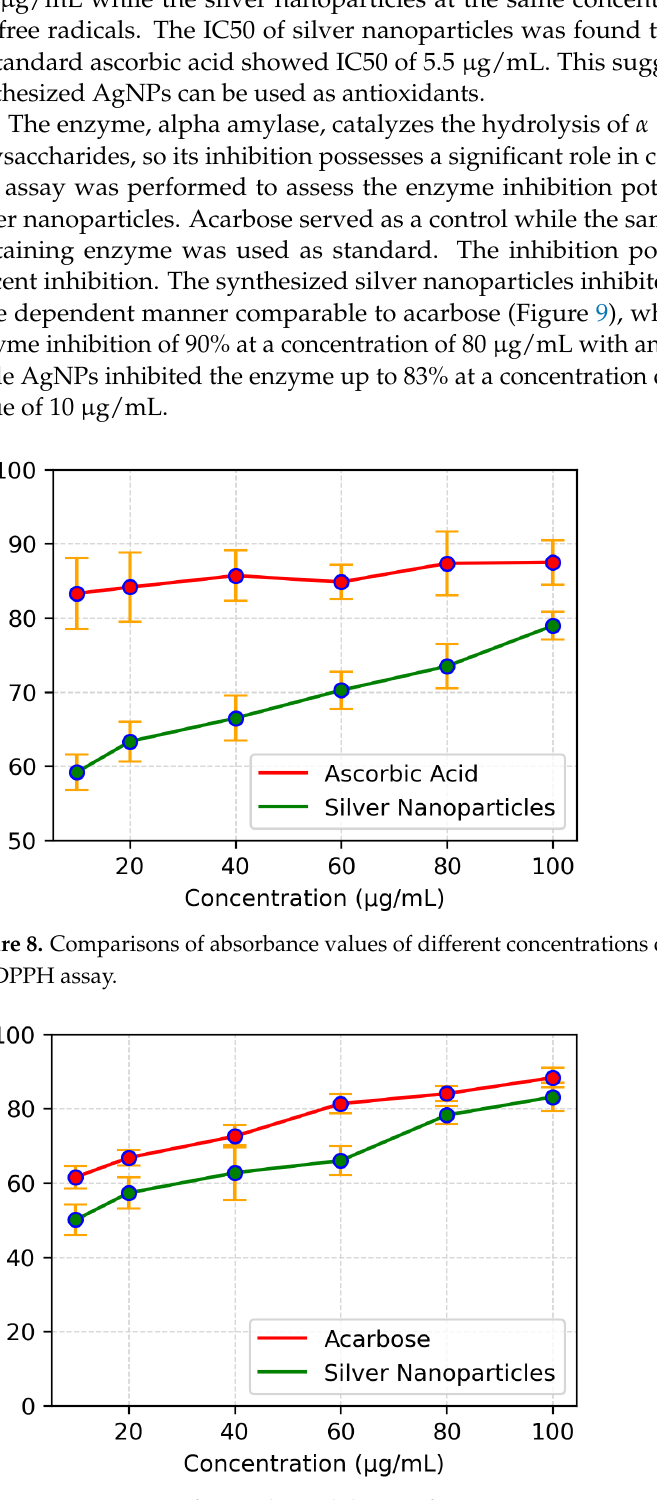
Figure 9. Comparison of α -amylase inhibition of various concentrations of AgNPs and